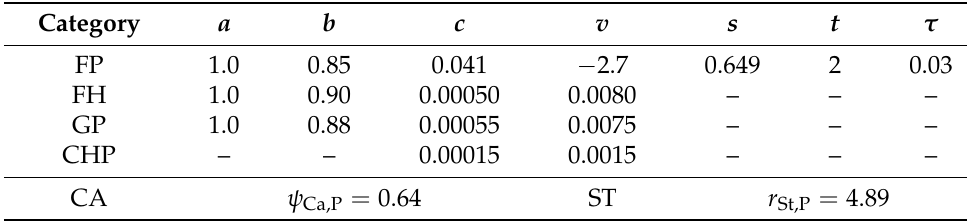
Table 2. Emission coefficients of the tested